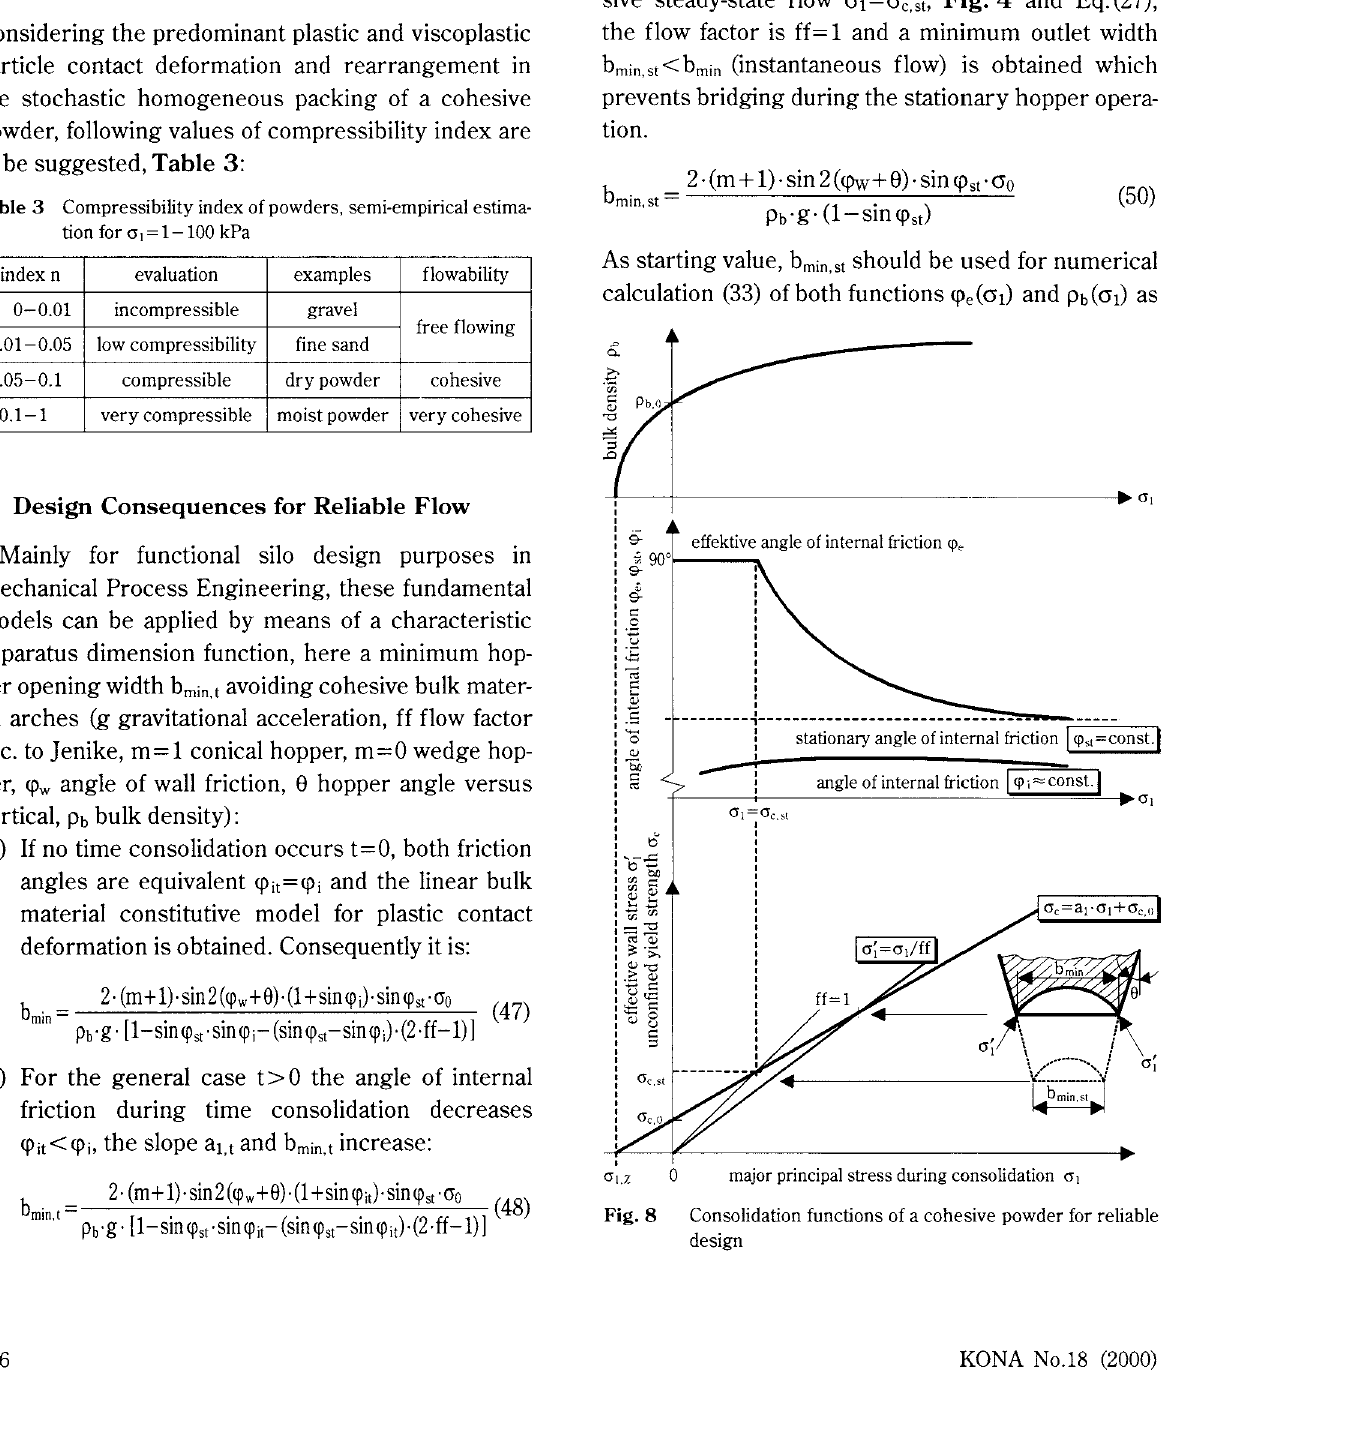
Fig. 8 Consolidation functions of a cohesive powder for reliable